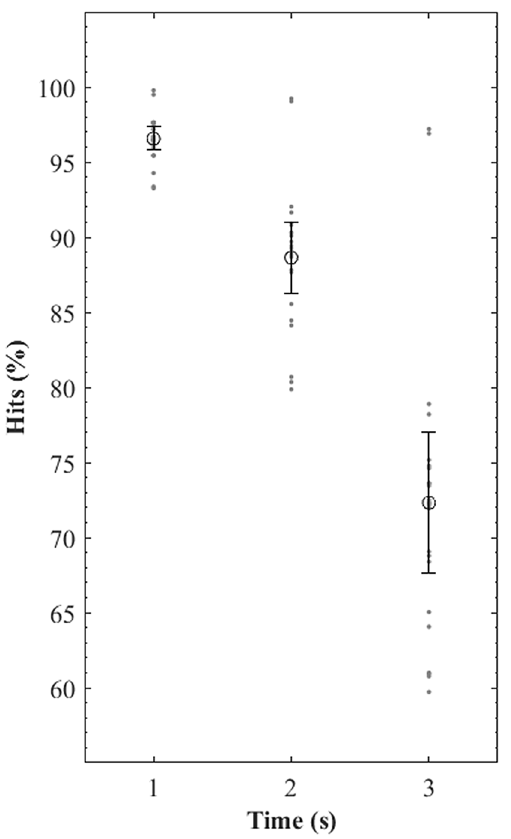
Figure 6. Representation of means (circles), standard deviations (bars), and individual values (dots) of percentage hits in determining players’ dominant regions (future positions coincided with a region associated with them) at different future time windows (one-, two-, and three-seconds